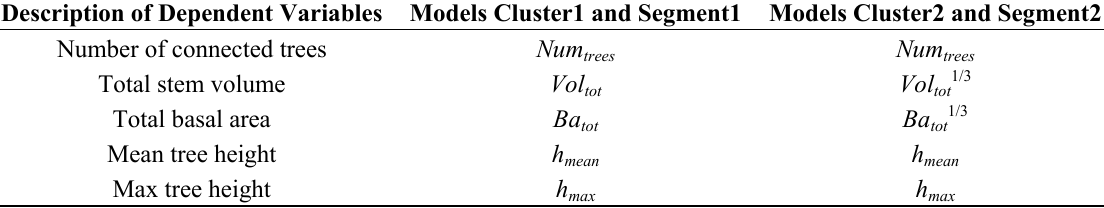
Table 4. Dependent variables derived from the trees connected to the clusters and segments